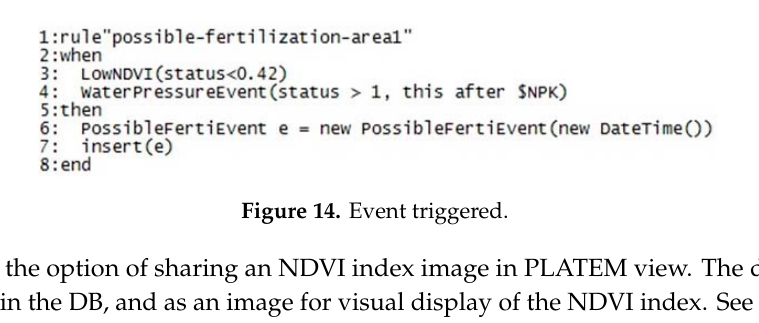
Figure 13. Average wind speed measured over 10 months.